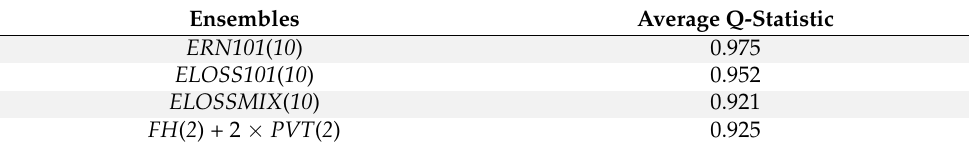
Table 7. Average